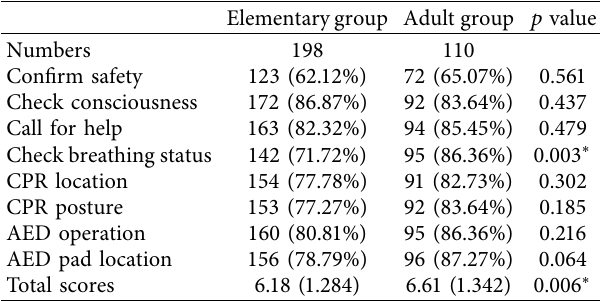
Figure 2: Difference of pre-/post-written exam after training. Data are expressed as score. ∗ indicates a significant difference. CPR: cardiopulmonary resuscitation; AED: automated external defibrillator. Table 3: Skill examination parameters of cardiopulmonary